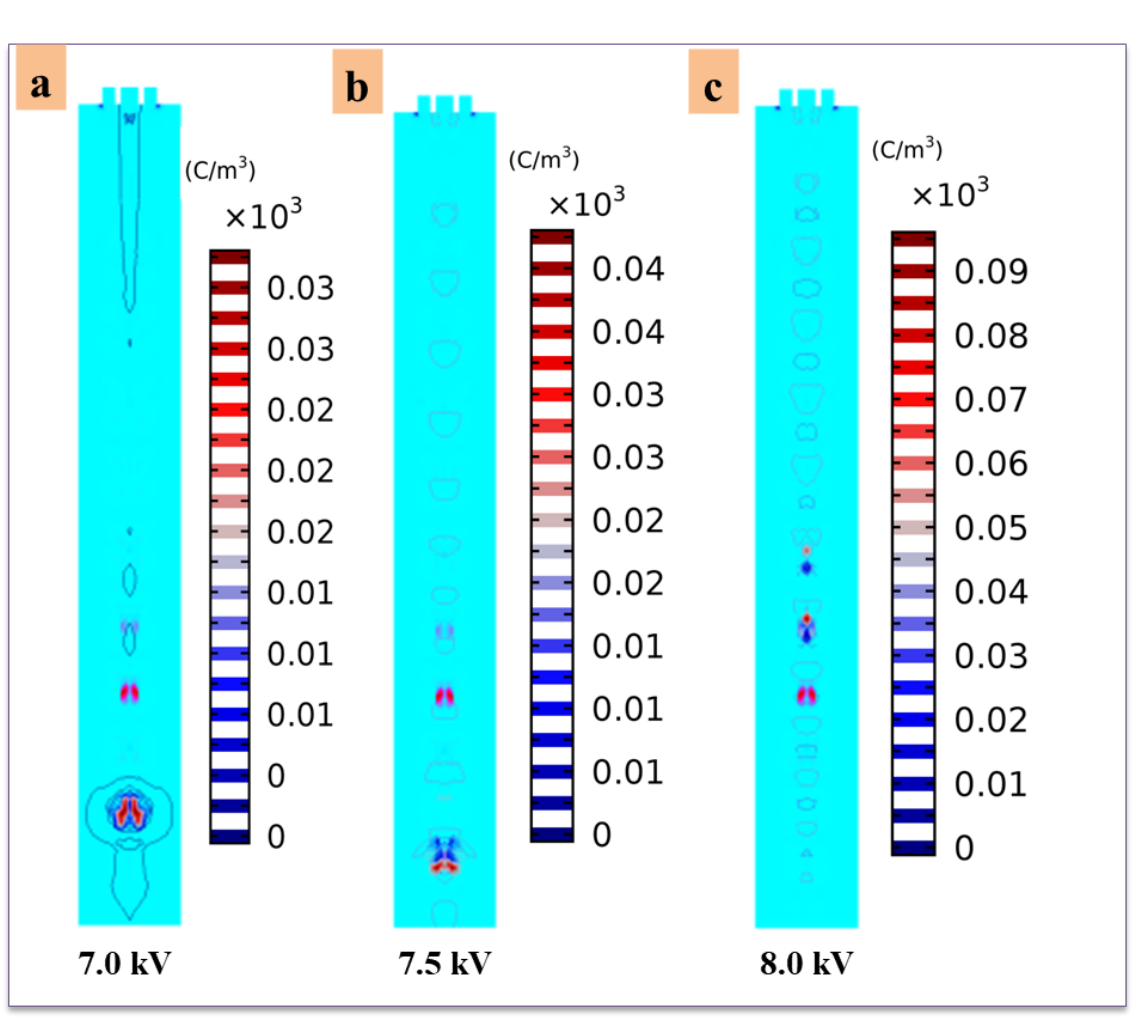
Figure 5. ( a – c ) are the space charge density profiles at the liquid and gas interface during micro- droplets formation based on nozzle pulse voltages of 7.0, 7.5 , and 8.0 kV, respectively .